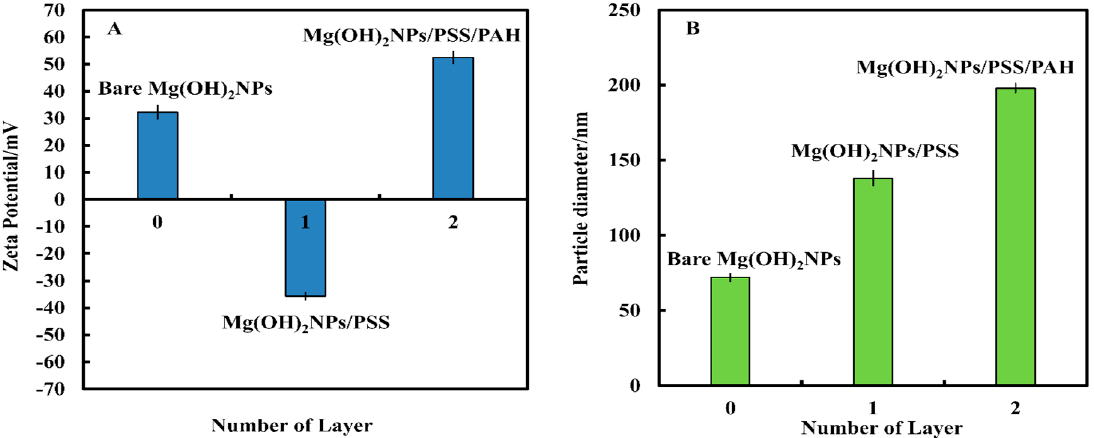
Figure 3. ( A ) The zeta potential and ( B ) particle size of bare-and polyelectrolyte-coated Mg(OH) 2